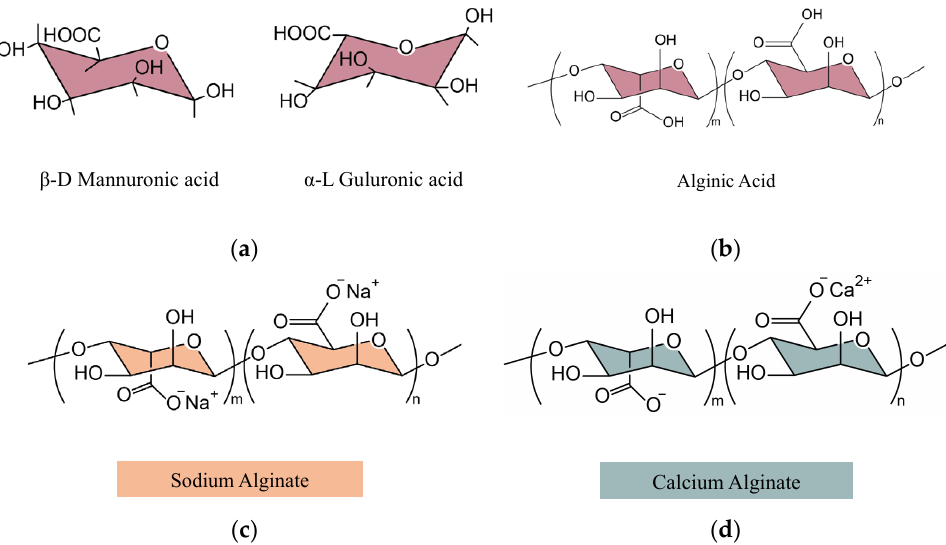
Figure 1. Chemical structure of ( a ) alginic acid G and M blocks, ( b ) A, ( c ) Na-A, and ( d ) Ca-A.